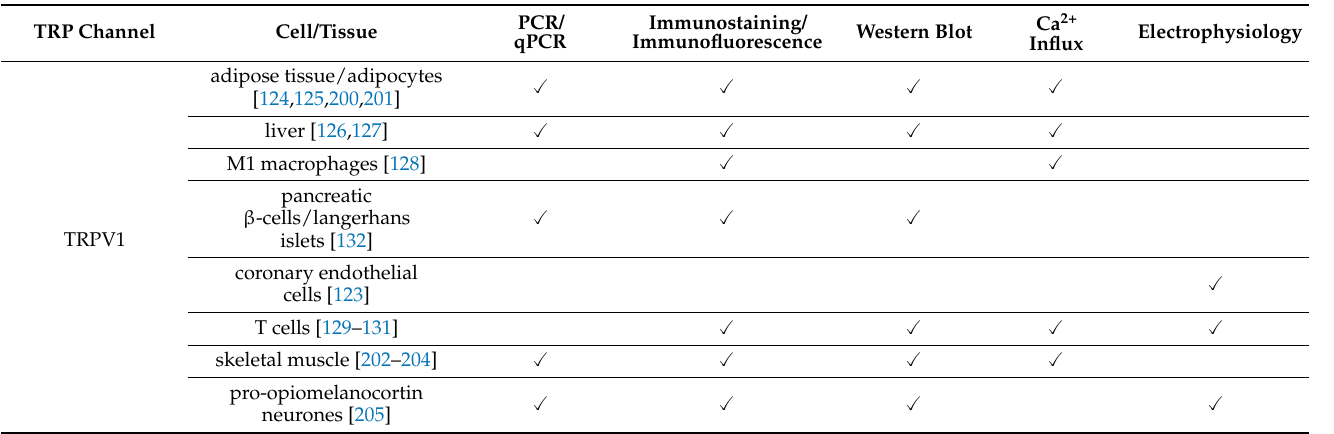
Figure 4. TRPV1, TRPA1 and TRPC5 expressions in metabolic tissues. ( a ) Liver, ( b ) adipose tissue, ( c ) pancreas and ( d ) skeletal muscle. All these TRPs are detected in the pancreas either as transcripts or functional proteins. TRPV1 is found in all metabolic tissues (liver, adipose tissue, pancreas and skeletal muscle). Additionally, TRPA1 and TRPC5 (either as homo or heterodimers) are expressed in the skeletal muscle and adipose tissue, respectively. The question tag ( ? ) represents expressions yet to be confirmed: TRPA1 in the liver and adipose tissues, and TRPC5 in the skeletal muscle. Table 2. Evidence for TRPV1, TRPA1 and TRPC5 expression on cells and in tissues involved in metabolic